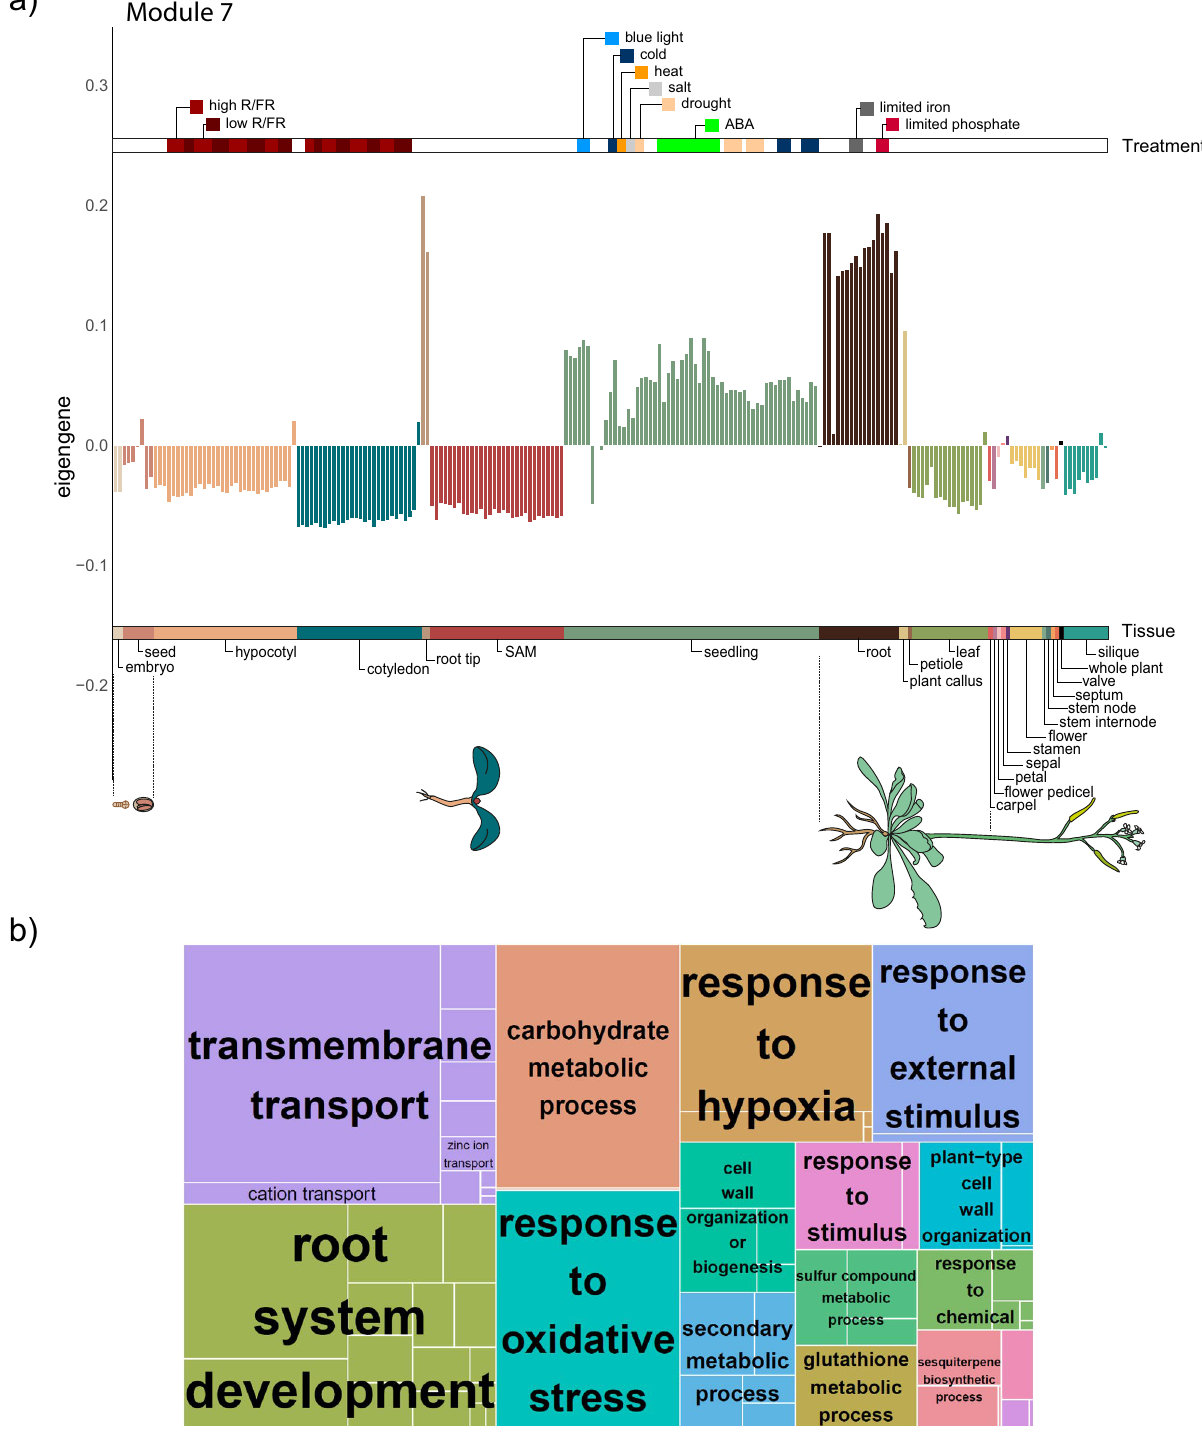
Figure 4. Module 7 expression and functions. ( a ) Barplot of representative expression (eigengene) by transcriptome in module 7, which is enriched in genes expressed and participating in root development. Each bar represents the expression in one transcriptome, organized by tissue and ordered by age from younger (left) to older (right). The lower bar describes which tissue belongs to each color, while the upper one the different experimental treatments of each transcriptome. ( b ) Treemap of enriched biological functions in module